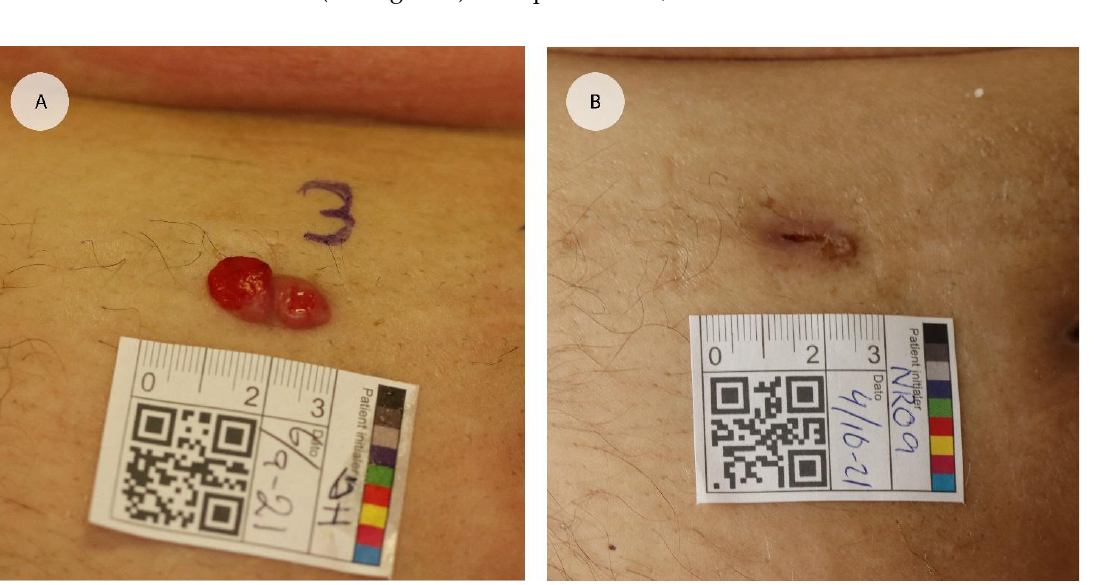
Figure 2. Example of affect in an endometrial cancer metastasis treated with calcium electroporation. ( A ) Digital clinical photograph at baseline before one calcium electroporation treatment in local anaesthesia. ( B ) One month after calcium electroporation treatment.